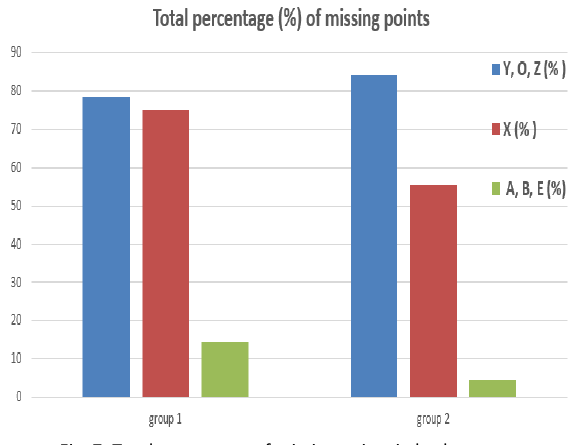
Fig. 7: Total percentage of missing points in both groups .